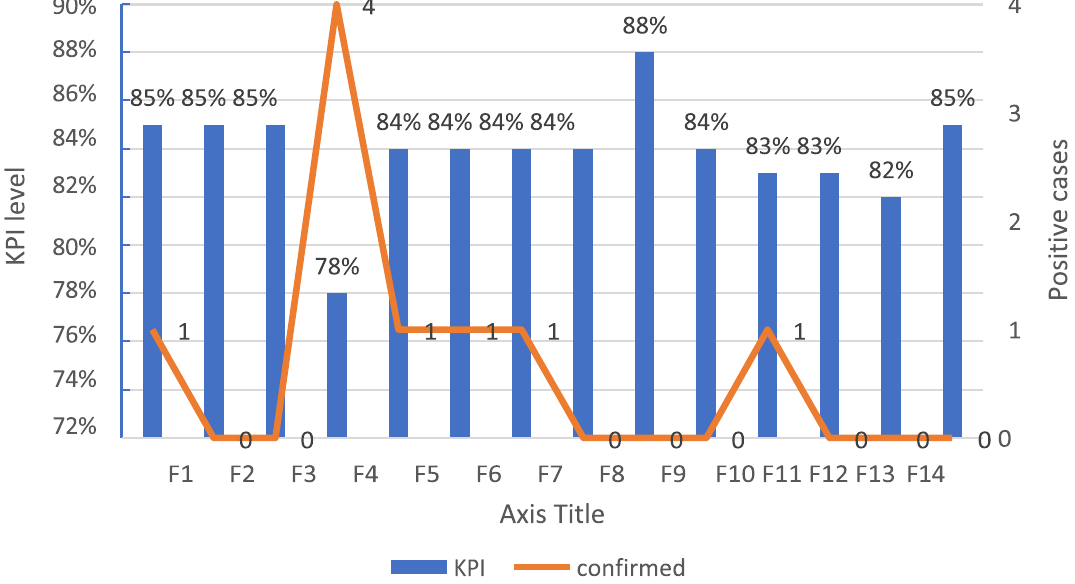
Figure 1. Shows each faculty’s Readiness–Capacity KPIS score and the distribution of confirmed cases (N = 9): The blue columns represent the faculty’s Readiness–Capacity KPIS score. The distribution of COVID-19 cases among the faculties is represented by the orange